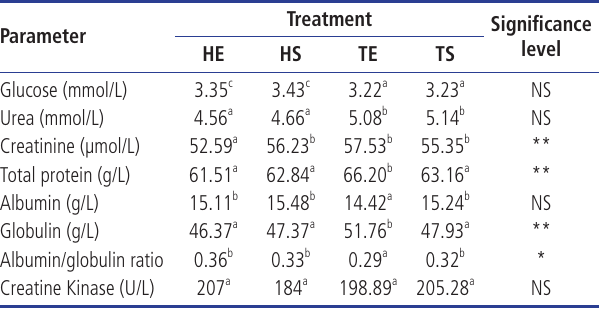
Table 3. Means of blood chemistry parameters of tethered and herded Nguni goats accommodated in earth floors and slatted floors Treatment Significance Parameter